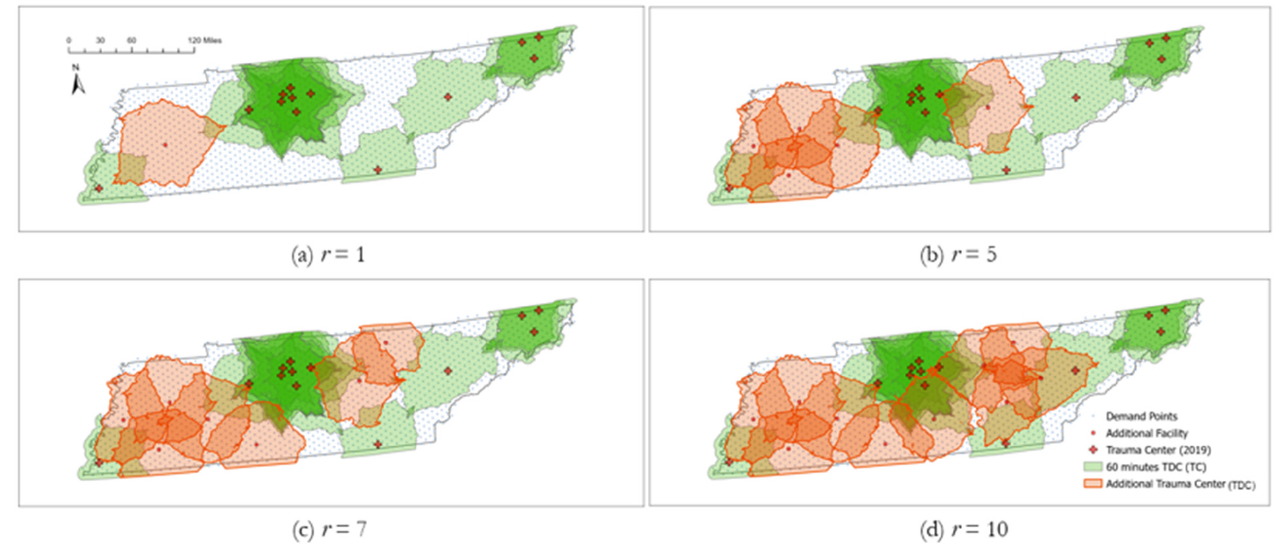
Figure 11. Locations of additional trauma centers according to the number of facilities available. ( a ) r = 1; ( b ) r = 5; ( c ) r = 7; ( d ) r = 10.